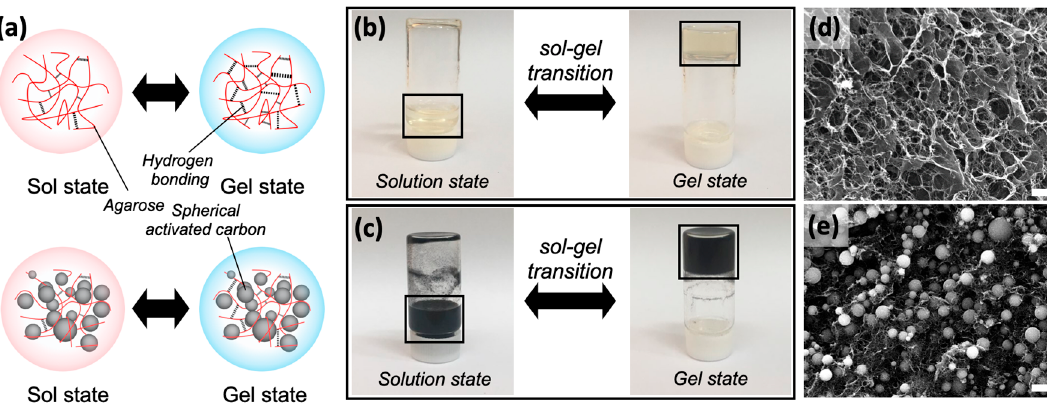
Figure 2. ( a ) Schematic illustration of the thermal sol–gel transition of the pure agarose and the composite gel, having fine and sparse agarose networks due to abundant and deficient hydrogen bonding, respectively. ( b ) Photos of the agarose sol at 90 °C (left) and the gel at room temperature (right), ( c ) Photos of the agar/SAC mixture sol at 90 °C (left) and the composite gel at room temperature (right). ( d , e ) Scanning electron microscopy images of cross-sectional views of freeze-dried ( d ) the agarose gel and ( e ) the agar10/SAC10 composite gel. Scale bars in ( d ) and ( e ) indicate 1 and 10 μ m, respectively.